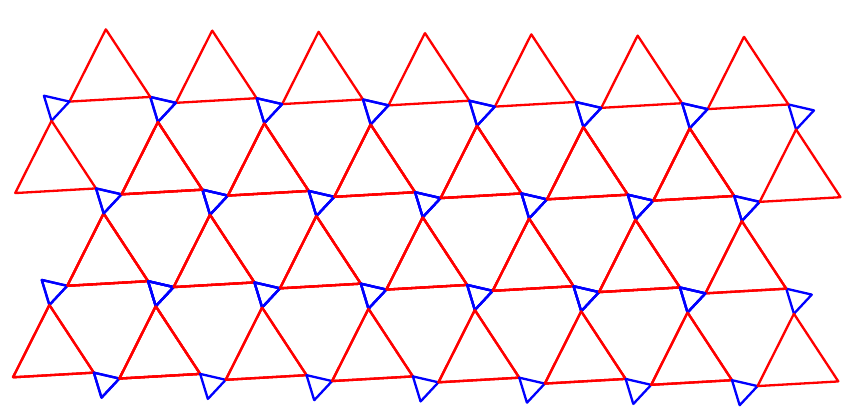
Fig. 25: Tiling with two types of regular triangles and equal hexagons (D).